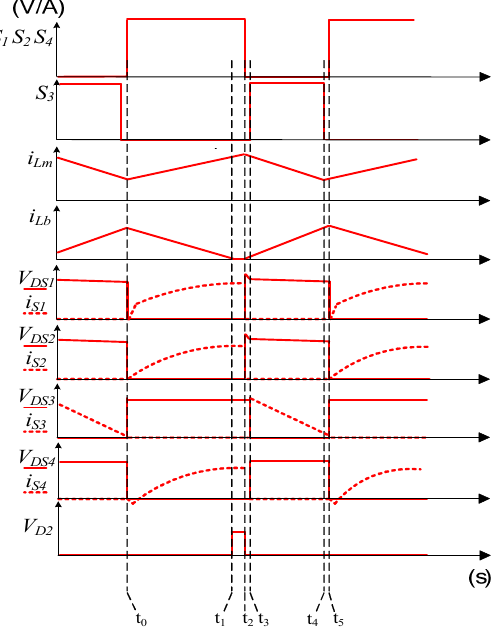
Figure 5. Waveform diagram of operation of main components in Stage 2.